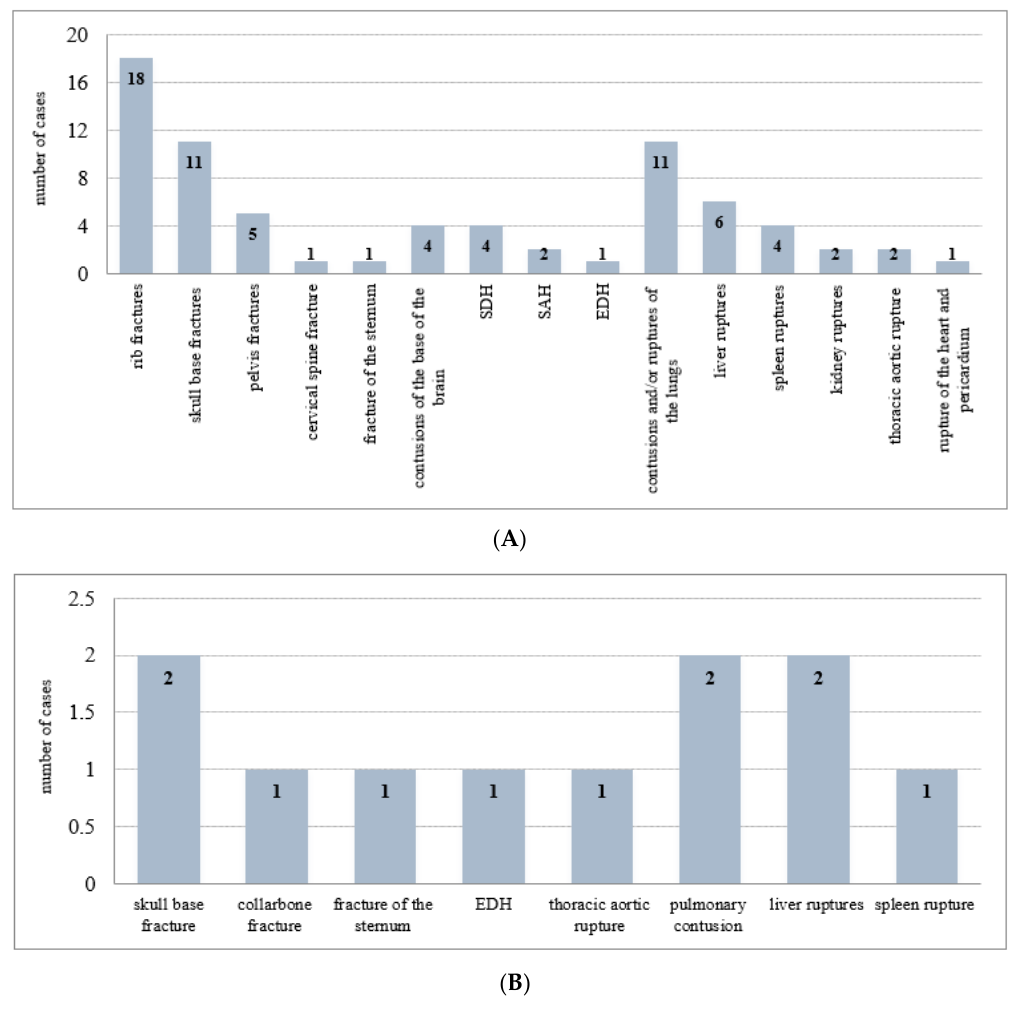
Figure 3. ( A ) The false negative cases of CT scans (73) for each type of injury. SDH—subdural hem- orrhage; SAH—subarachnoid hemorrhage; EDH—epidural hemorrhage. ( B ) The false positive cases of CT scans (11) for each type of injury. EDH—epidural hemorrhage. Repeated evaluation of CT scans revealed rib fractures (7), skull base fractures (3), subdural hemorrhage (1), pulmonary contusion (4), liver ruptures (2), spleen rupture (1), and kidney rupture (1). Discrepancy dropped from 26.9% to 20.8%.